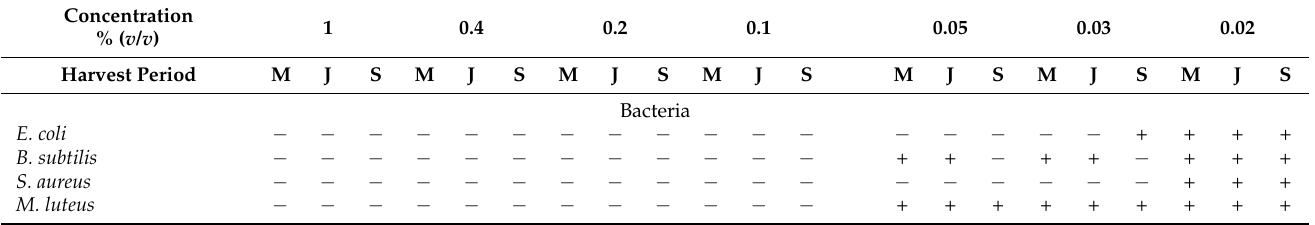
Table 4. Determination of MIC values of Artemisia herba-alba essential oil against bacteria.